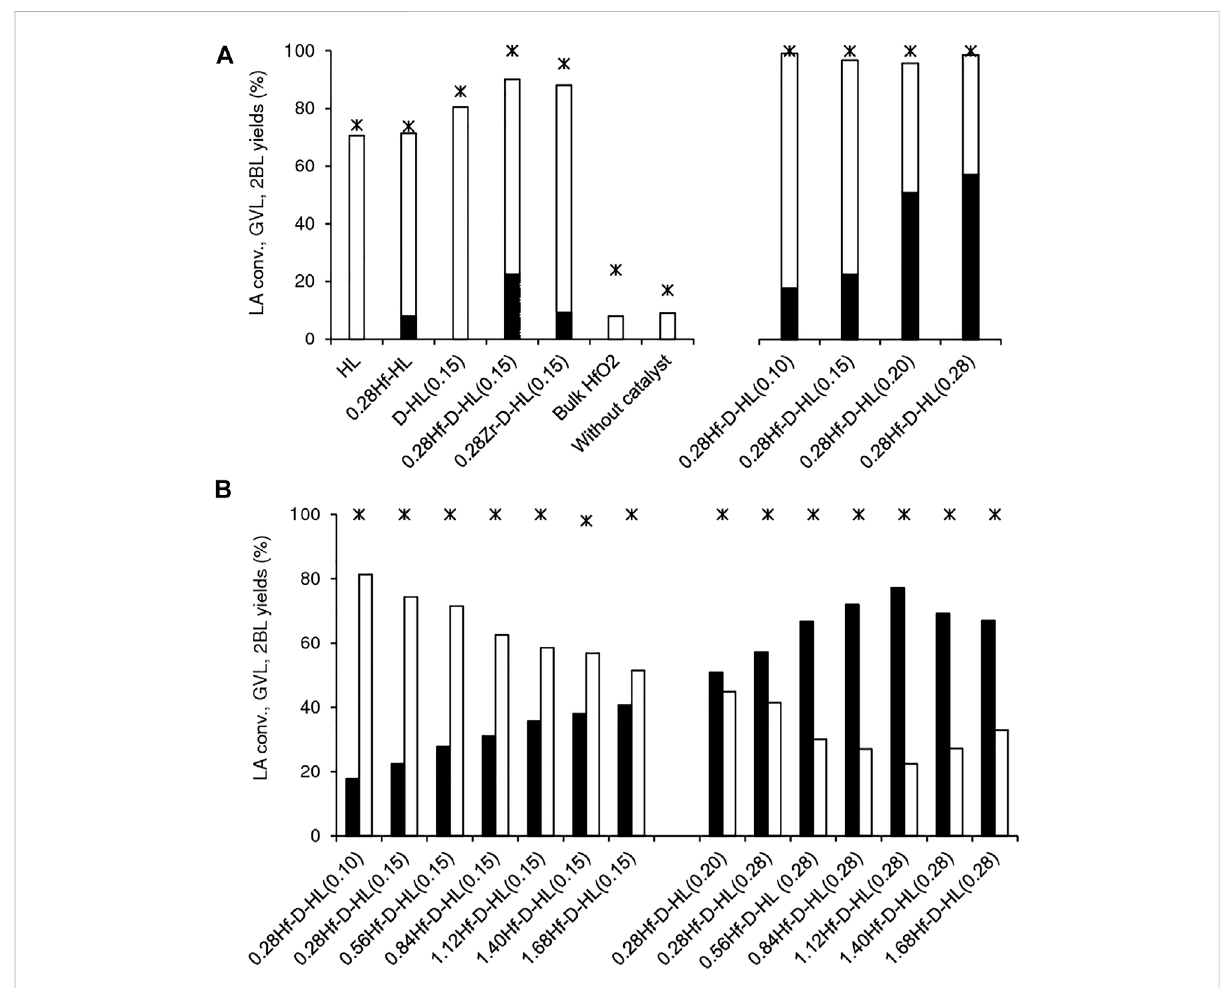
FIGURE 7 Catalytic performances of theprepared catalysts (A,B) for LA conversion (*) to GVL (black bars) and 2BL (white bars). Tests without catalyst or in the presence of HfO 2 are included for comparison (A) . Reaction conditions: 0.45 M LA in 2BuOH, 200 ° C, 24